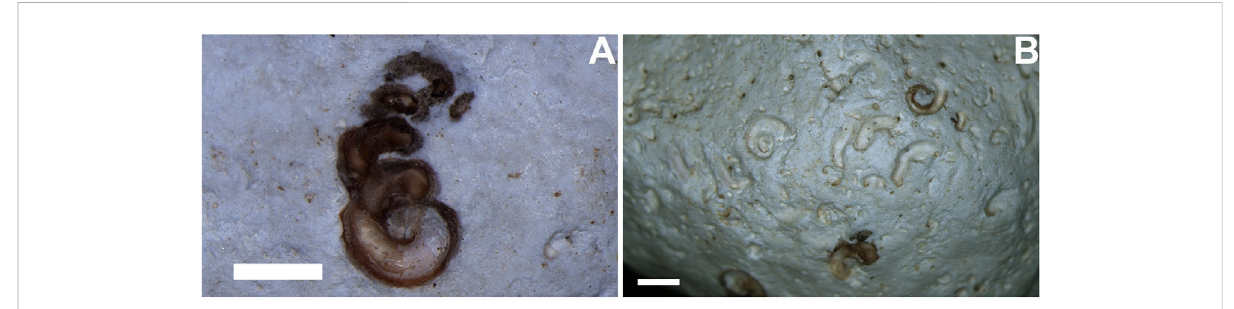
FIGURE 8 Vermetidgastropodassociatedwithbioerosiononencrusted Thaishaemastoma (ULLPA458)fromPuntaNegra,(TenerifeIsland). (A) vermetid gastropod with tight and loose coiling, responsible for compound forms of Renichnus – Santichnus (compare with Panel 4C). (B) the same specimen of Thais haemastoma with Renichnus and Santichnus and remains of vermetid gastropods. Scales: 2